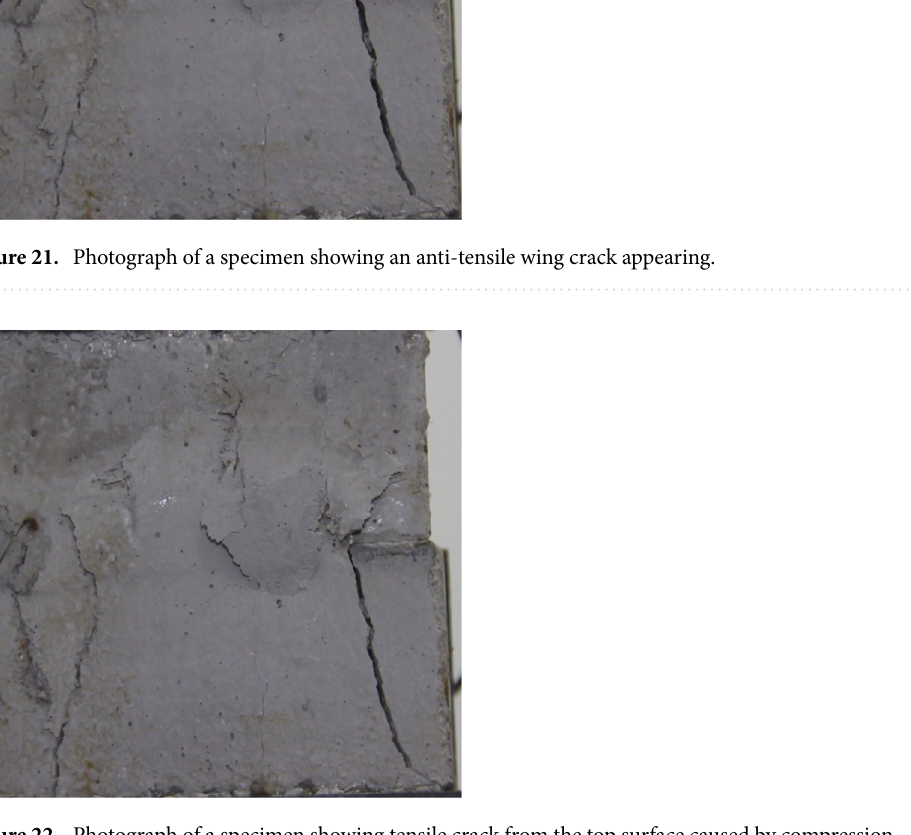
Figure 22. Photograph of a specimen showing tensile crack from the top surface caused by compression